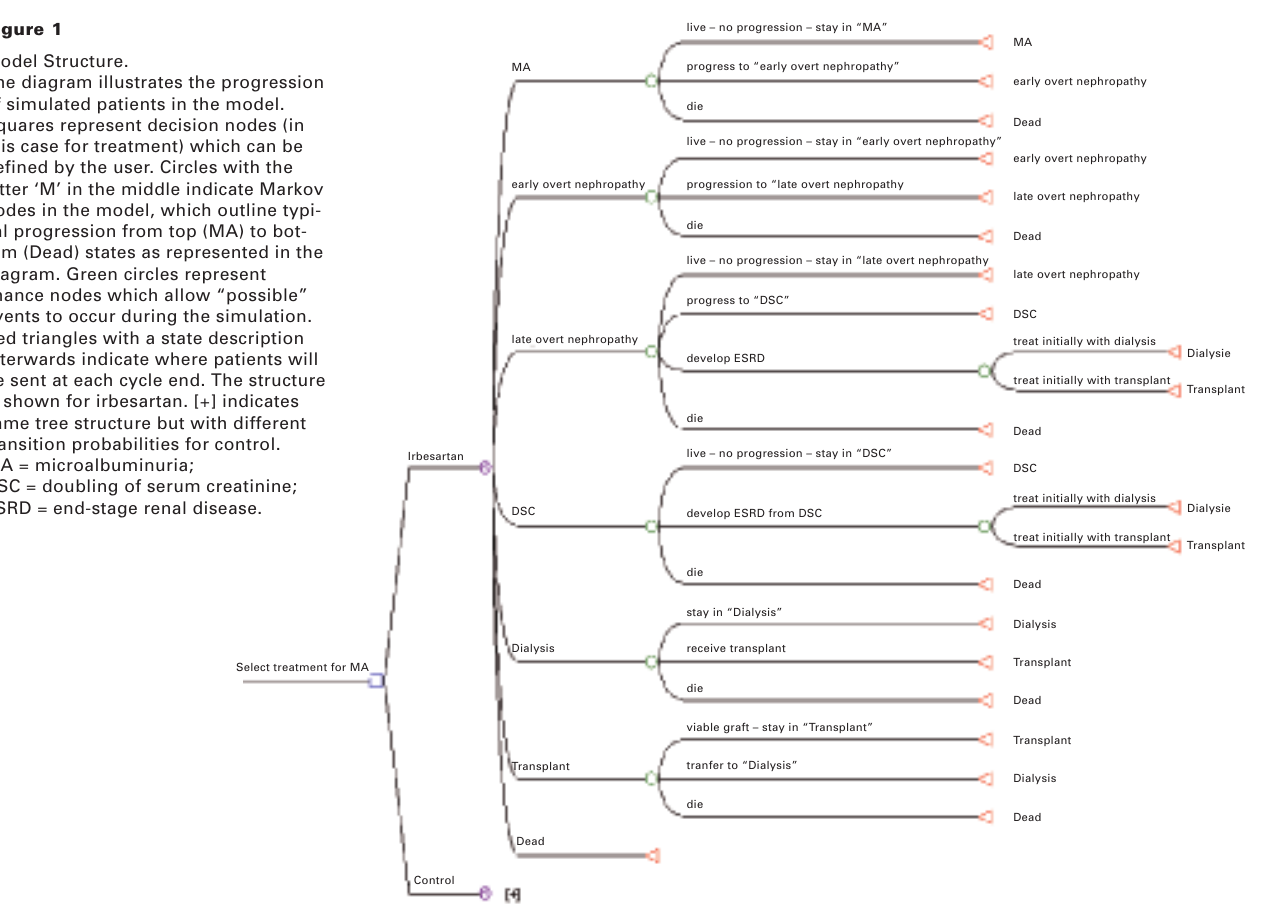
Figure 1 Model Structure. The diagram illustrates the progression of simulated patients in the model. Squares represent decision nodes (in this case for treatment) which can be defined by the user. Circles with the letter ‘M’ in the middle indicate Markov nodes in the model, which outline typi- cal progression from top (MA) to bot- tom (Dead) states as represented in the diagram. Green circles represent chance nodes which allow “possible” events to occur during the simulation. Red triangles with a state description afterwards indicate where patients will be sent at each cycle end. The structure is shown for irbesartan. [+] indicates same tree structure but with different transition probabilities for control. MA = microalbuminuria;